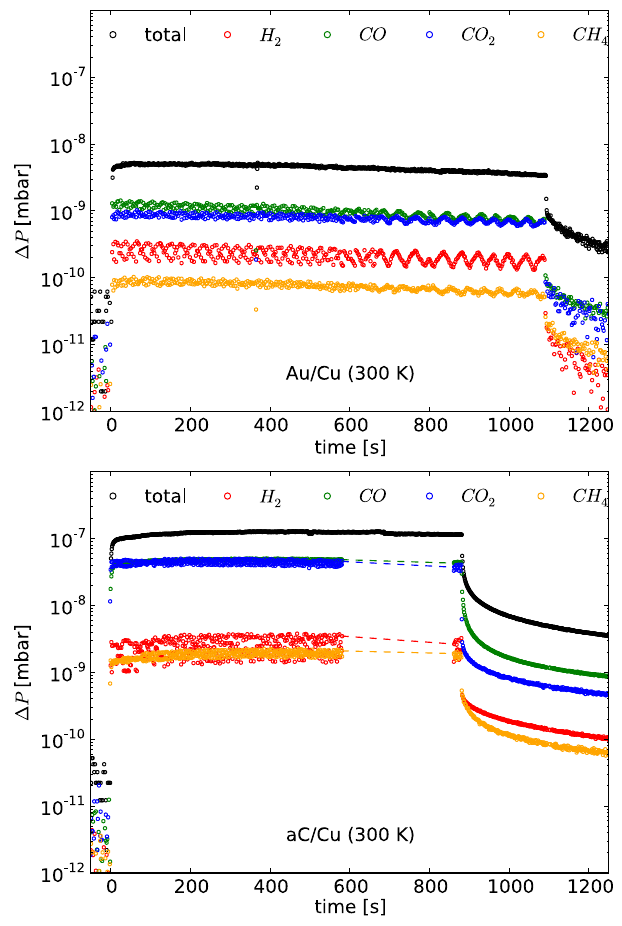
FIG. 5. Heavy-ion-induced pressure rises at 300 K target tem- perature. Partial pressure rises ( (cid:2) P ) of H 2 , CO, CO 2 , CH 4 , and total pressure rises measured for the Au = Cu and aC = Cu samples continuously bombarded under (cid:2) ¼ 0 (cid:2) with 1 : 4 MeV = u Xe 18 þ ions are shown.